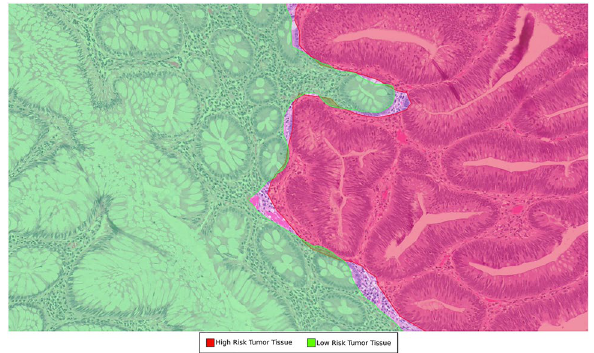
Figure 2. Labelling of “high-risk” (red) versus “low-risk” (green) regions based on the ground truth. A tile is labeled high-risk if there is overlap with any amount of high-risk ground truth annotations. Otherwise, the tile is labeled as low-risk. In this example, the highlighted tile would be labeled high-risk. The same rule was also applied to AI annotations. If a tile contains any amount of high-risk annotation given by AI, the tile is labeled as high-risk by AI, and low-risk